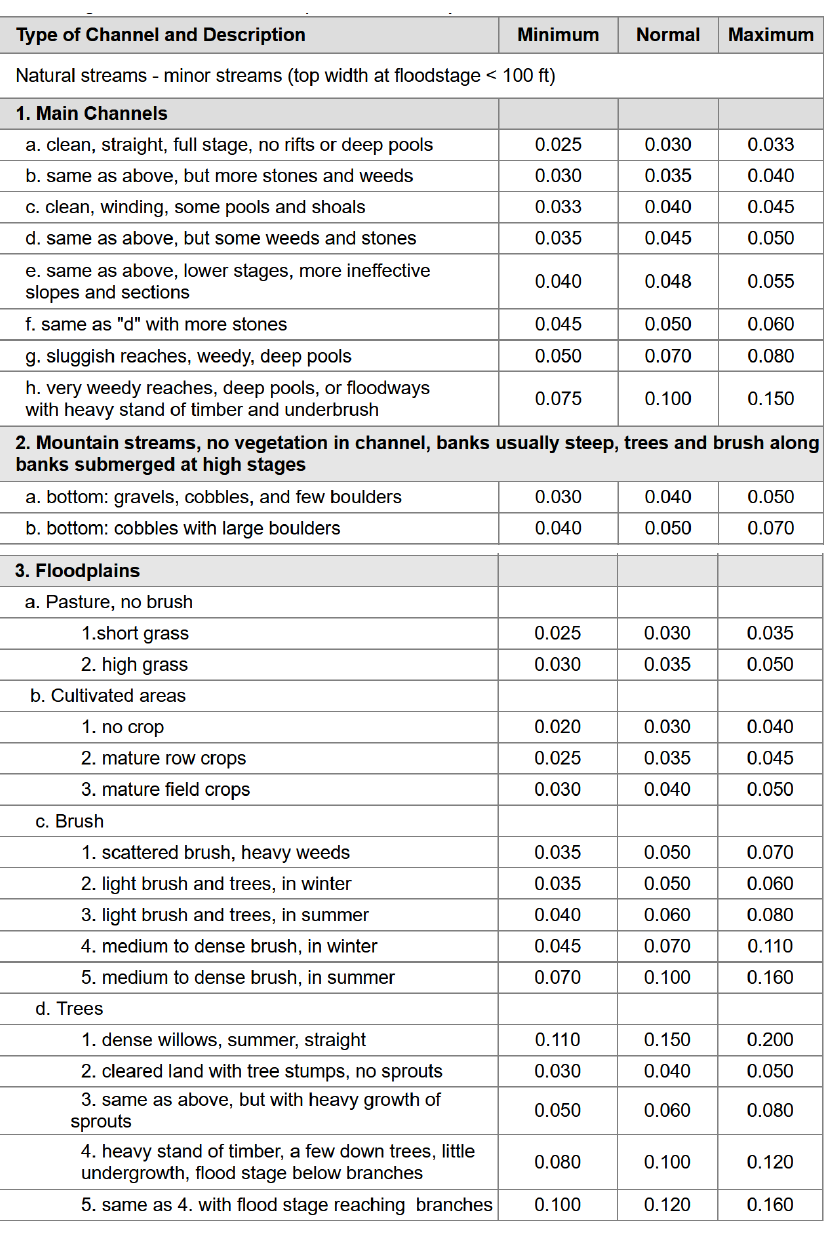
Figure 2. Example of Tabulated Manning’s coefficients for Channels from